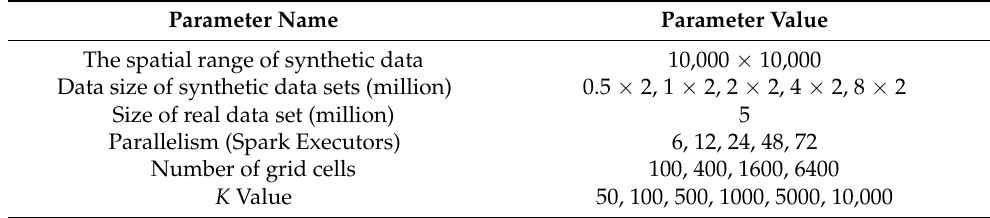
Table 1. Experiential data